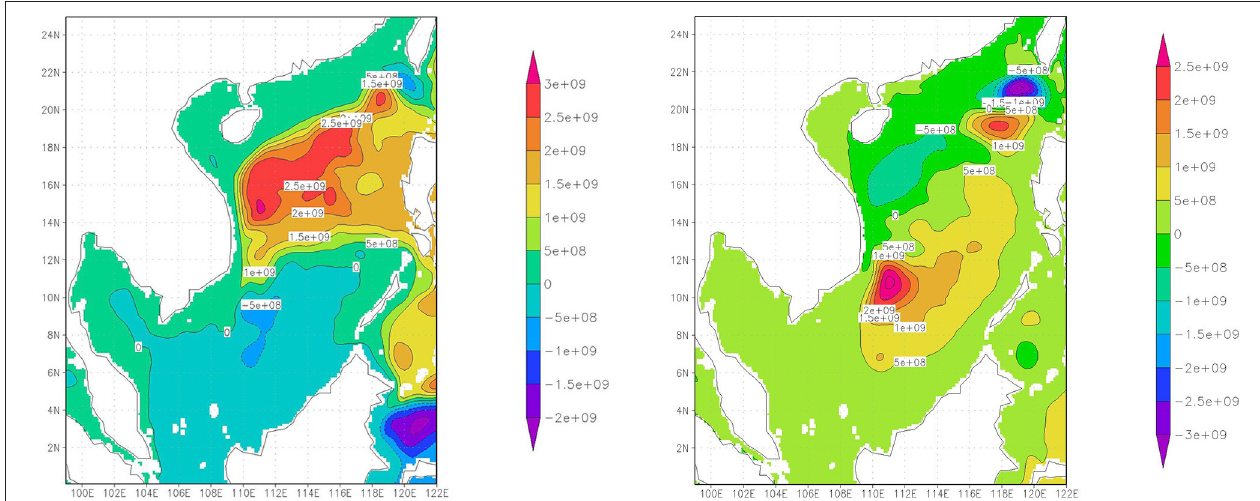
FIGURE 3 | Dominant patterns of interannual variability of summer season barotropic stream function in the South China Sea, the coefficients of which are used in the presentation in Figure 4 and in the mapping efforts shown in Figure 5 . Currents follow the gradients of the stream function, clockwise around a center of high (red) values, and counterclockwise around centers with negative (blue) values. Unit: kg s − 1 (kg/s). Courtesy: Zhang Meng.